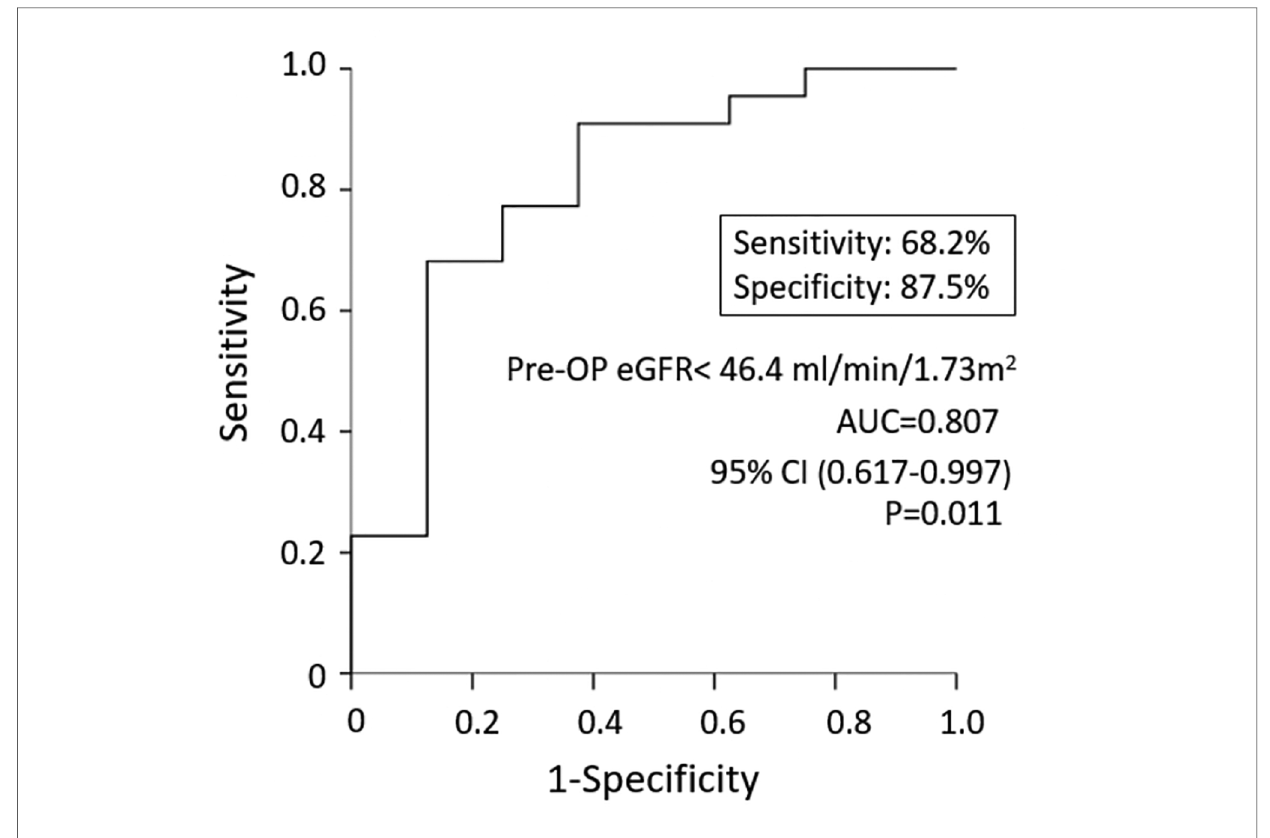
FIGURE 3 Preoperative eGFR predict permanent CKD in LDLT recipients with